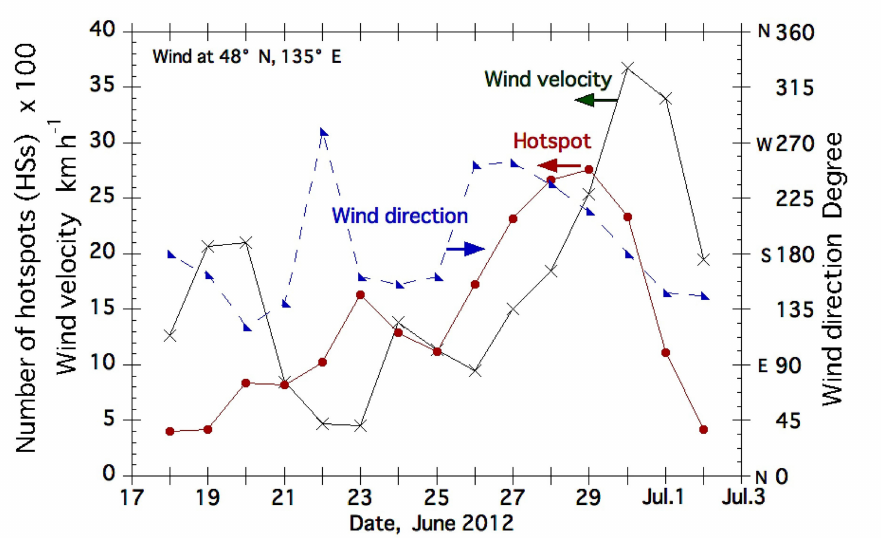
Figure 14. Wind conditions at the lower-level (925 hPa) and active fires during the top fire-period (1)29Jun’12 (from June 18 to July 2,